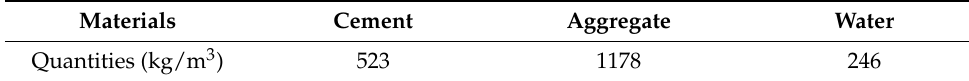
Table 2. Concrete mixture design.